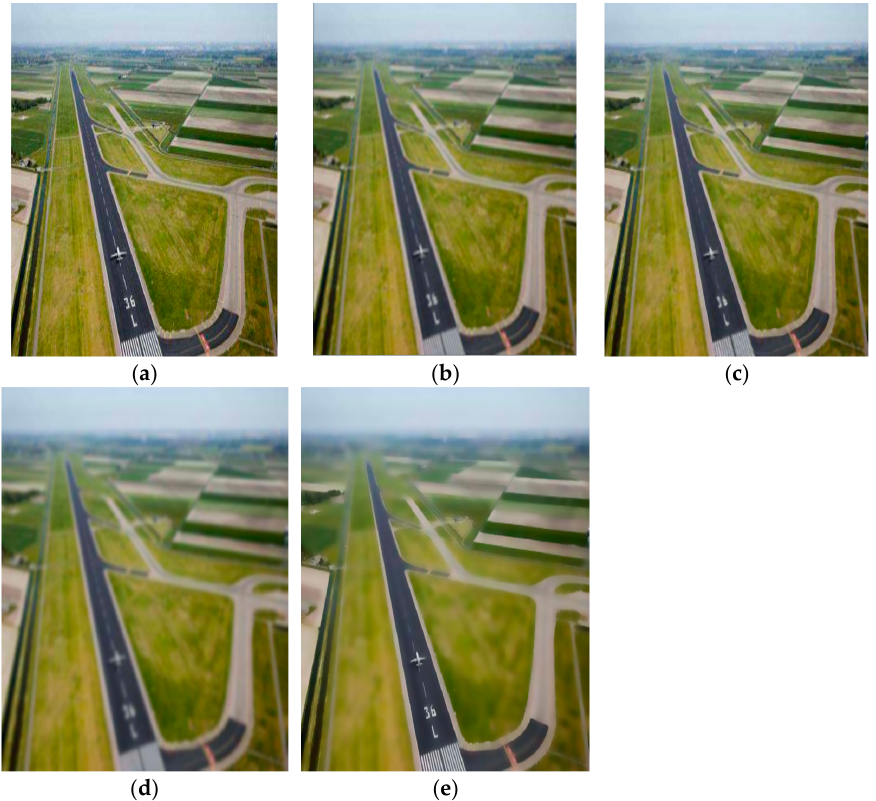
Figure 9. Common noise filter. ( a ) Original airport image; ( b ) mean filtering; ( c ) median filtering; ( d ) Gaussian filtering; ( e ) bilateral filtering. Appl. Sci. 2 023, 13, x FOR PEER REVIEW